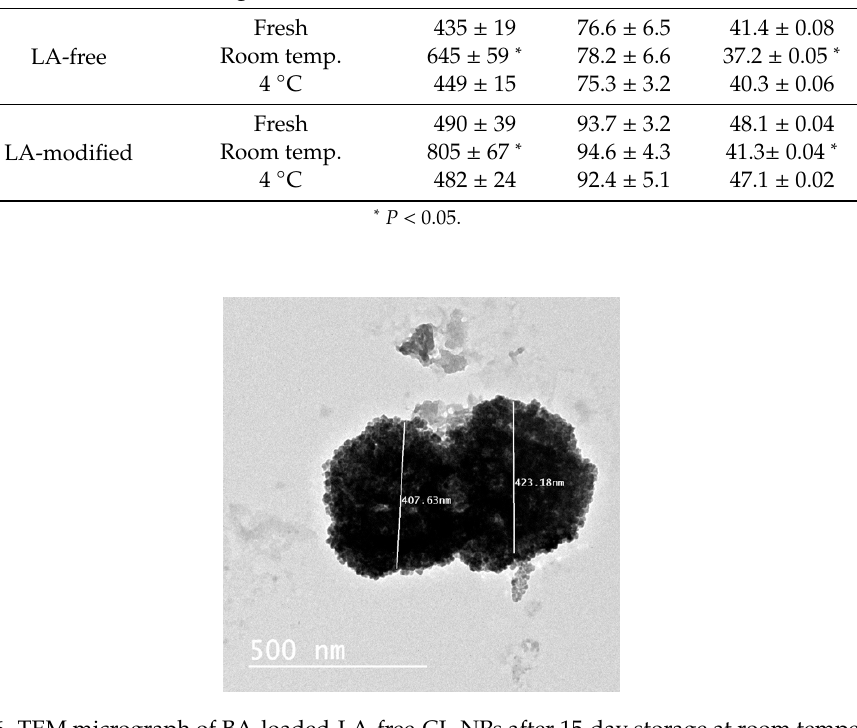
Figure 6. TEM micrograph of BA-loaded-LA-free-CL-NPs after 15-day storage at room temperature showing particles aggregation. showing particles